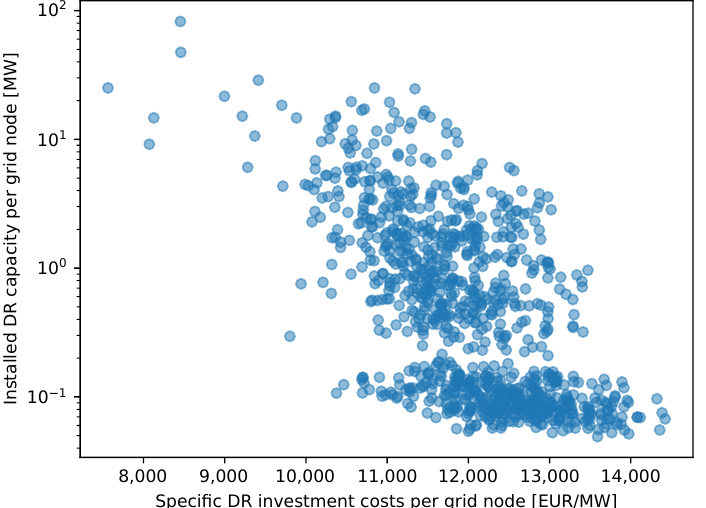
Figure 8. Correlation of the DR expansion and the average investment cost of the aggregated DR units per grid node (one dot per grid node).